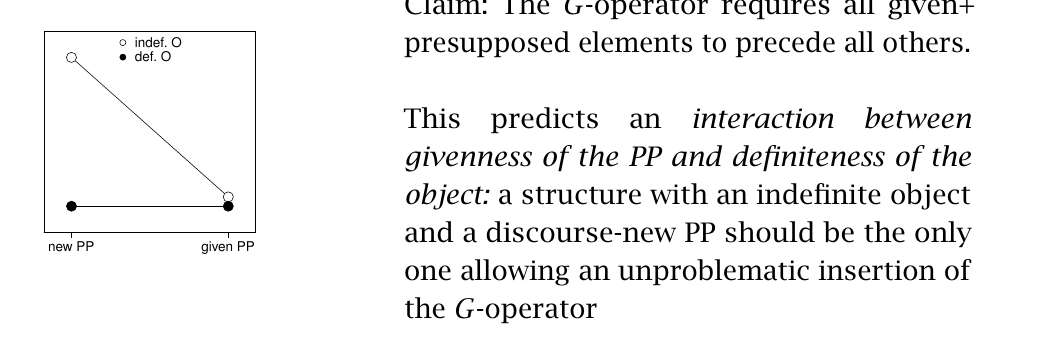
Predictions derived from Kuˇcerová 2007 , 2012 for experiment 2